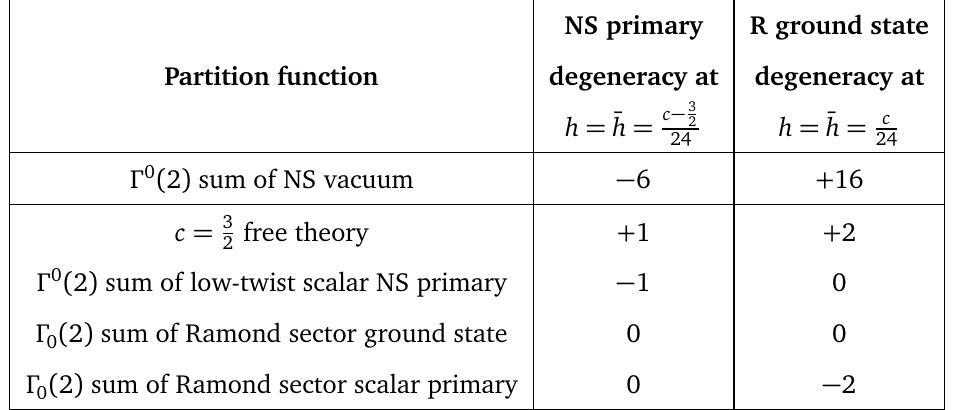
Table 1: Contributions to degeneracies by different partition func- tions. The first row is the original Maloney-Witten partition function. The rest can be added to cure the negativity in the density of primaries or to adjust the Ramond ground state